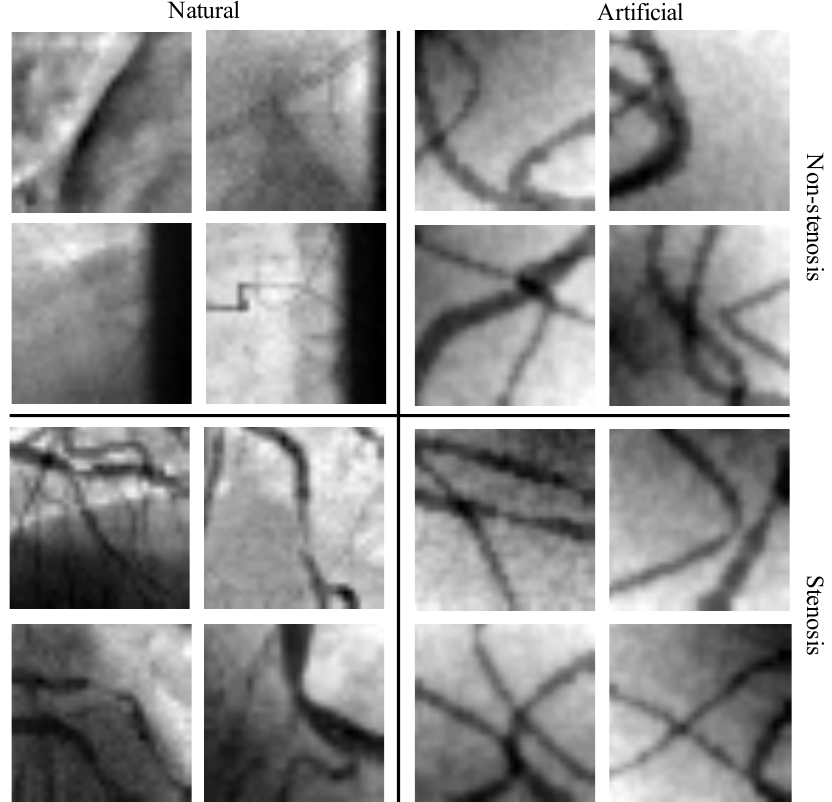
Figure 10. Natural and artificial samples from stenosis datasets. Left images are real patches from X-ray Coronary Angiography (XCA), and the right-side images are the artificial patches. The upper-side sampled patches with non-stenosis, and the lower-side are positives cases of stenosis.